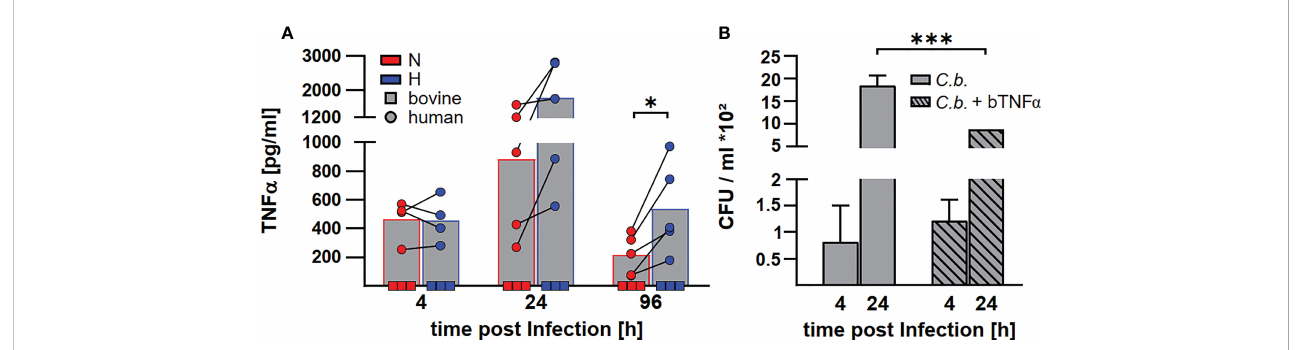
FIGURE 9 C. burnetii replication in infected bovine macrophages correlates with the lack of TNF a secretion. (A) Human macrophages from four different donors (circle) and three independent bovine macrophage preparations from two bovine donor animals (square) were infected with C. burnetii NMII for 4, 24 and 96 h under normoxia (N) or hypoxia (H). TNF a levels were analyzed by ELISA. Mean ± SD, paired t-test. *p<0.05. (B) Three independent bovine macrophage preparations from two bovine donor animals were infected with C. burnetii NMII and either left untreated or treated with 10ng/ml bTNF a . Cells were incubated for 4 and 24 h under normoxia. Bacterial counts were determined by counting colony forming units (CFU). Shown is a representative experiment performed with technical triplicates out of two experiments with similar results. Mean ± SD, unpaired t-test. ***p<0.01,